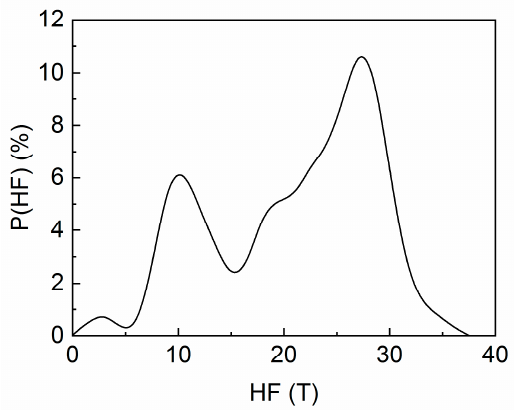
Table 2. The fitting results of the Mössbauer spectrum of the annealed sample, assuming the fitting model with 6 discrete magnetic sublattices, color coded as in the Figure 6.